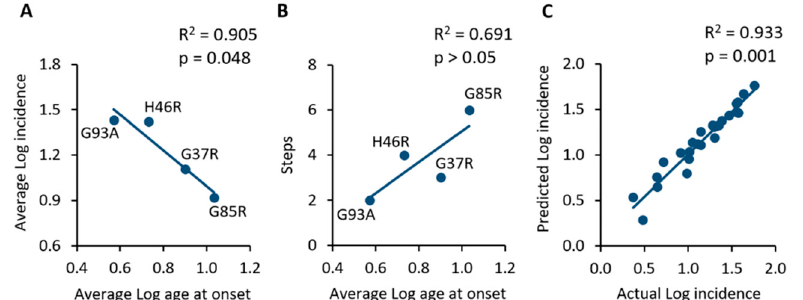
Figure 2. ( A ) Comparison of SOD1 mutant mouse populations showing an inverse correlation between the average age at onset and the average incidence in the same population. ( B ) The application of the Armitage and Doll model suggests that the lower the number of steps towards onset, the earlier the average age at onset of animals. ( C ) Linear regression and correlation of the actual incidence values extracted from primary studies and those predicted by the mathematical model. The strong correlation suggests the high predictability of the model.